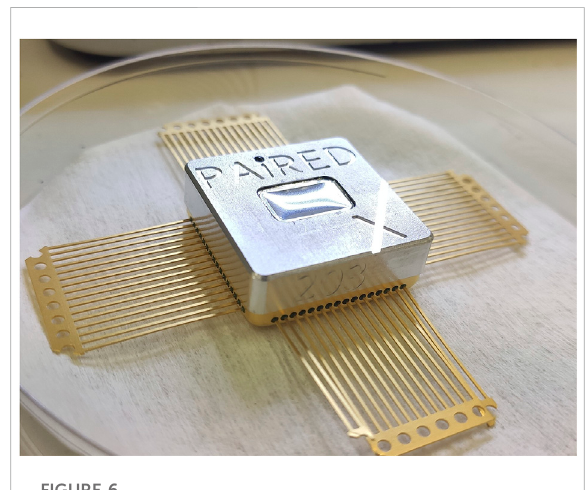
FIGURE 6 Photographofthecompact(2.6